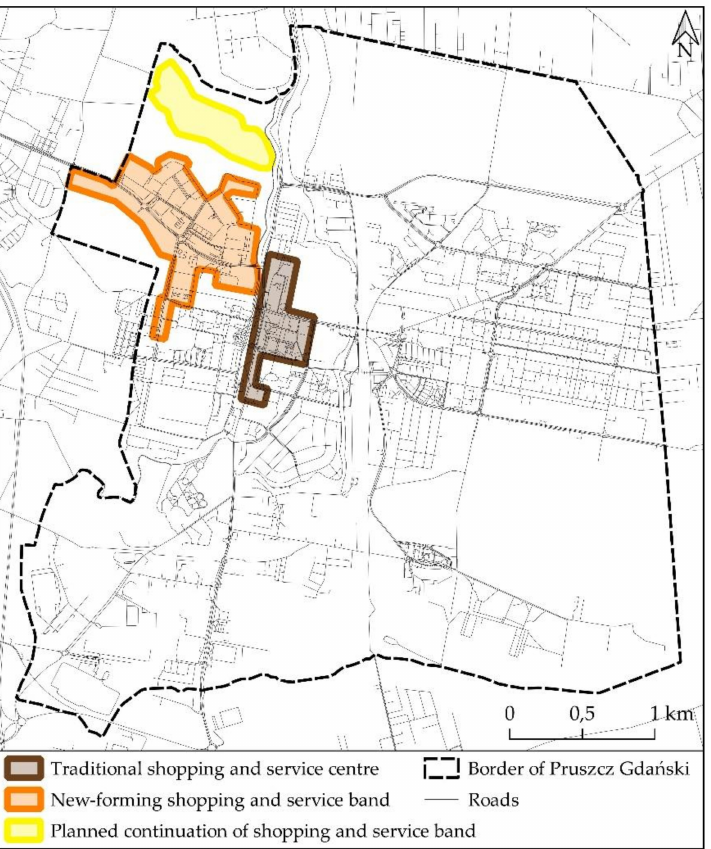
Figure 9. The emerging shopping and service band compared to the traditional one located in the town center (source: own elaboration based on